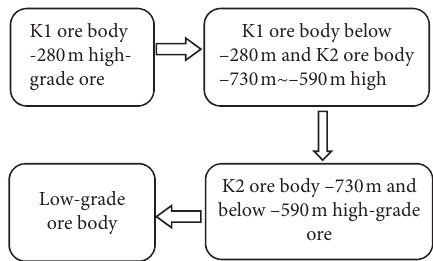
Figure 9: Numerical simulation calculation